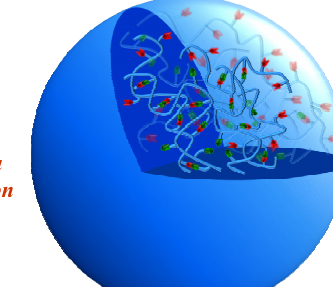
Scheme 2. Cartoon representation of the aggregation of a PVBT/PVBA blend